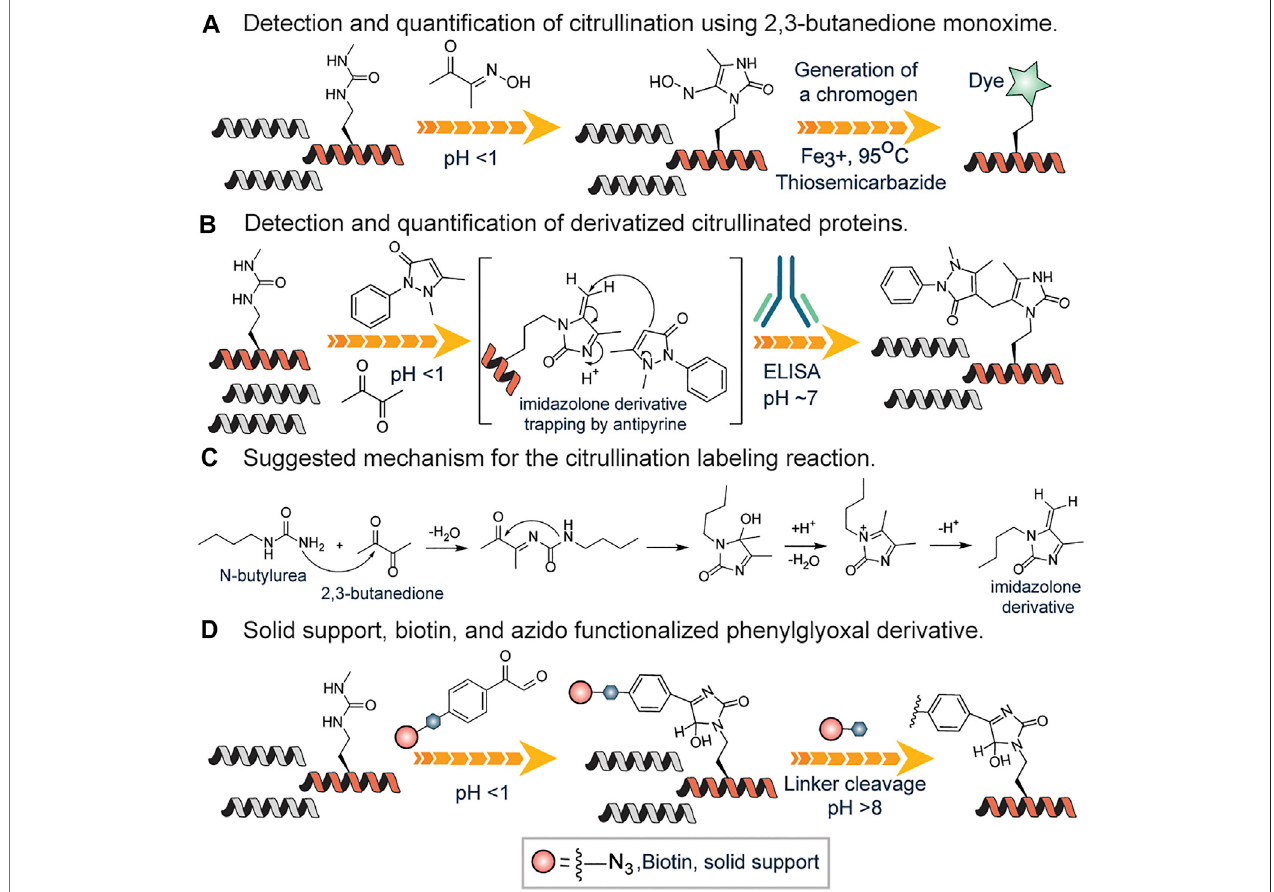
FIGURE7|(A) Colordevelopmentreagentassayofcitrullination using2,3-butanedione monoxime. (B) Antibody-basedapproachfordetectionand quanti fi cation of citrullination using antipyrine and 2,3-butanedione. (C) Proposed mechanism for the reaction of N-butyl urea with 2,3-butanedione, leading to the formation of the reactive imidazoline intermediate. (D) Solid-phase or af fi nity-based methods of detection and quanti fi cation of citrullinated proteins.